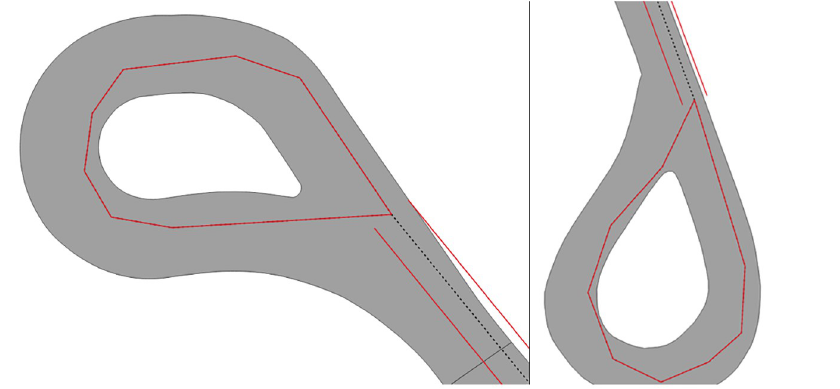
Fig 9. Examples of loops at the end of roads in Toronto which result in false dead